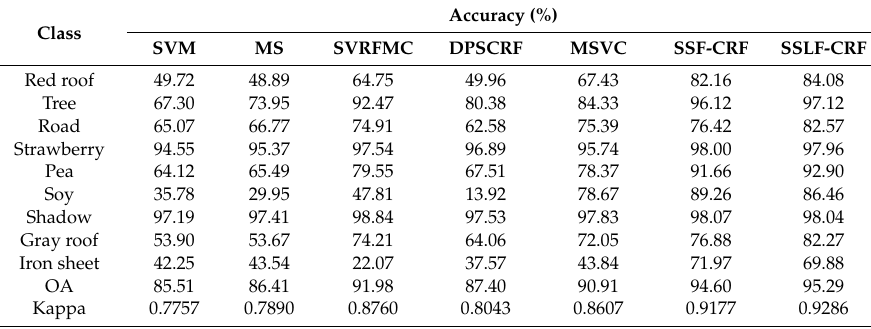
Table 3. The classification accuracies for the Hanchuan